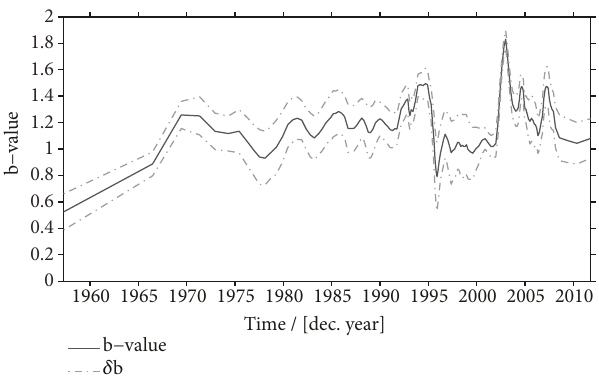
Figure 8: Temporal variation of b-value in ENTP region.